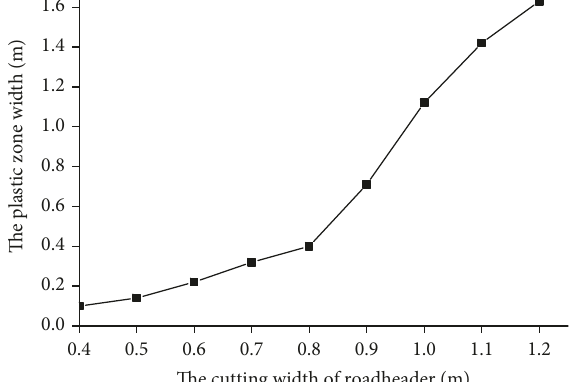
Figure 9: Plastic zone width versus cutting width.